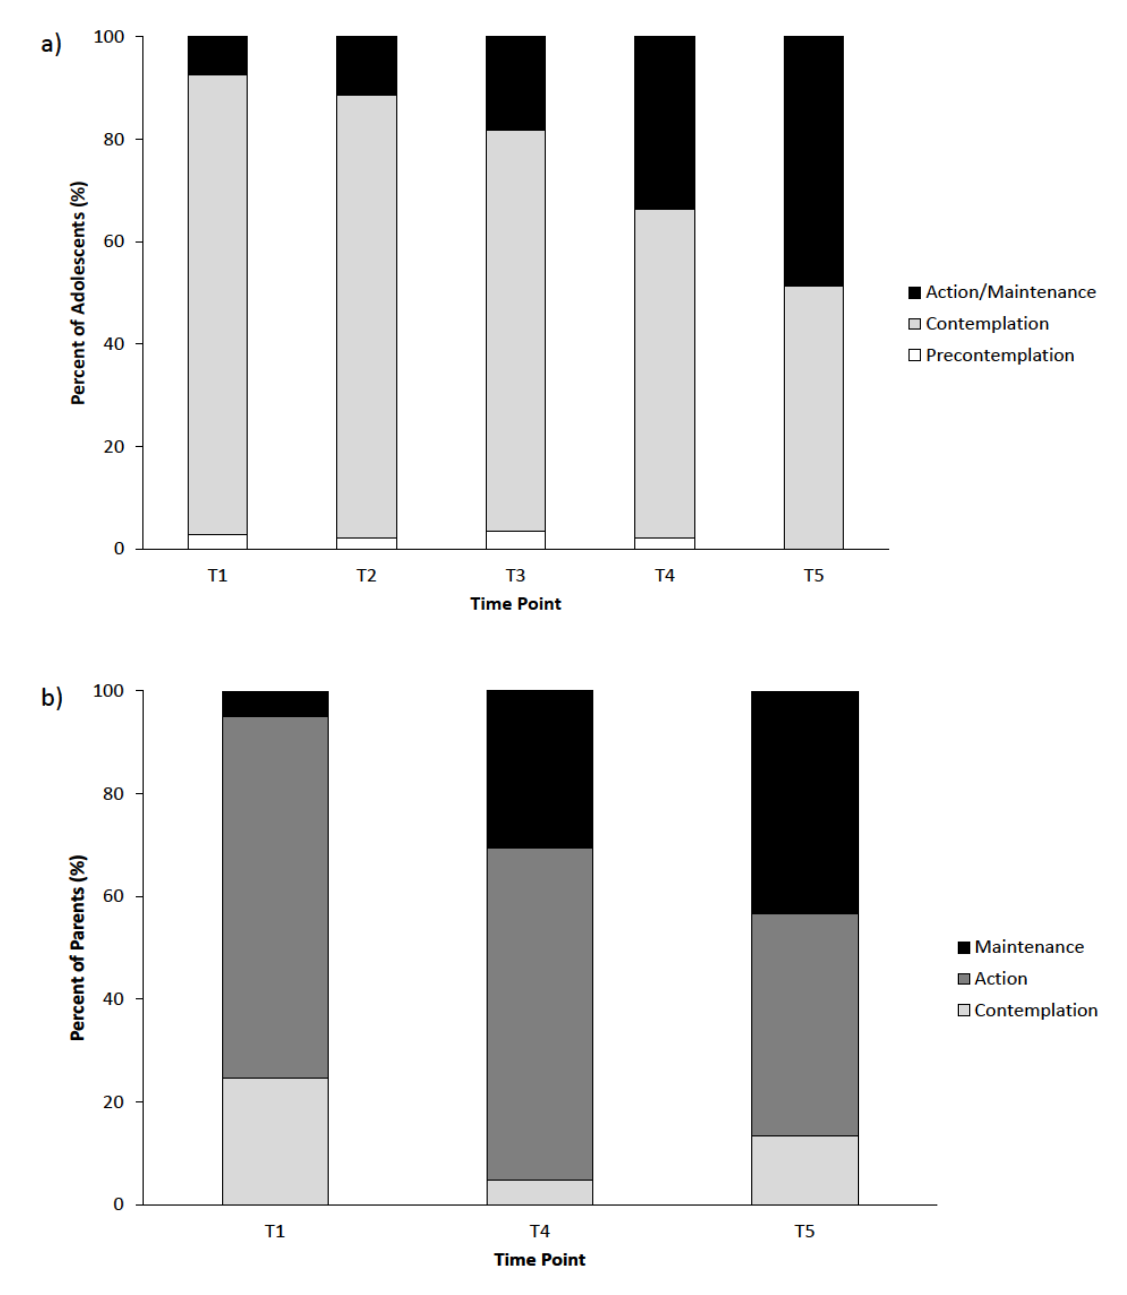
Figure 2. Frequency of stages of change over the course of treatment for ( a ) Pain Stages of Change Questionnaire for Adolescents (PSOCQ-A) and ( b ) Pain Stages of Change Questionnaire for Parents (PSOCQ-P). Note : T1 = Admission; T2 = 1 week after admission; T3 = 2 weeks after admission; T4 = Discharge (approx. 3 weeks after admission); T5 = 3 months after discharge. At each time point, patients were assigned to one stage of change according to their highest subscale mean score.